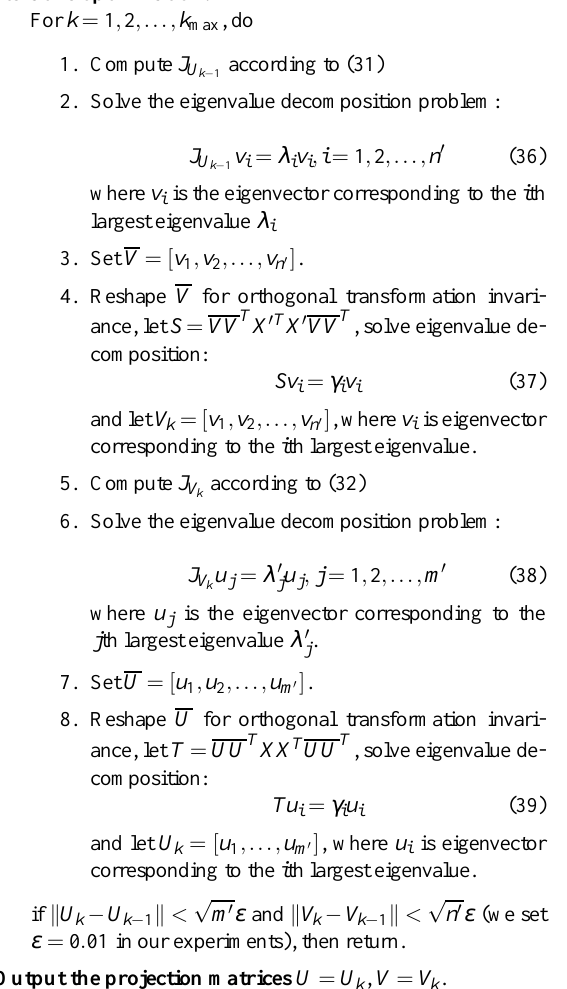
Figure 1: Algorithm 1: iterative solution with man- ually specified